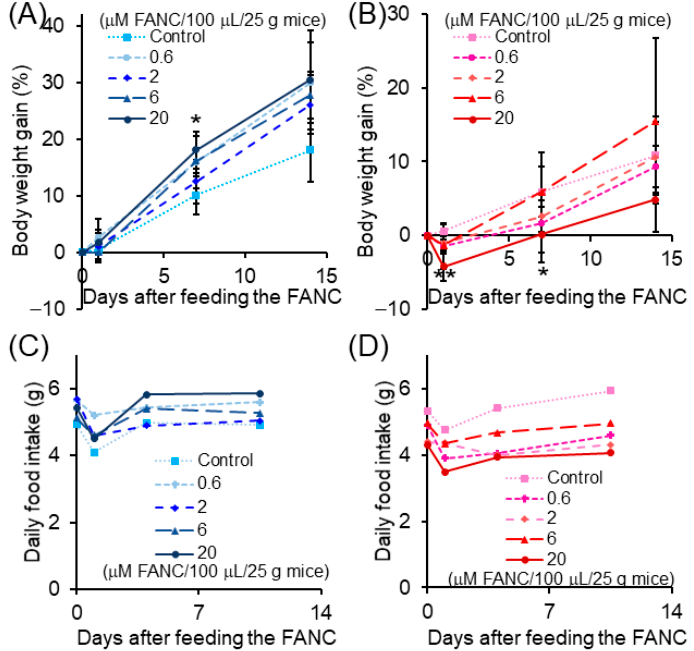
Figure 1. Body weight gain and daily food intake of ICR mice after feeding a single dose of FANC. Body weight gain of ( A ) male and ( B ) female mice. ( C ) Male and ( D ) female mice’s daily food intake was calculated from day 0–1, day 1–7, and day 7–14 using one mouse. Data are expressed as the mean ± SD ( n = 5). * p < 0.01, ** p < 0.001, significantly different to control.